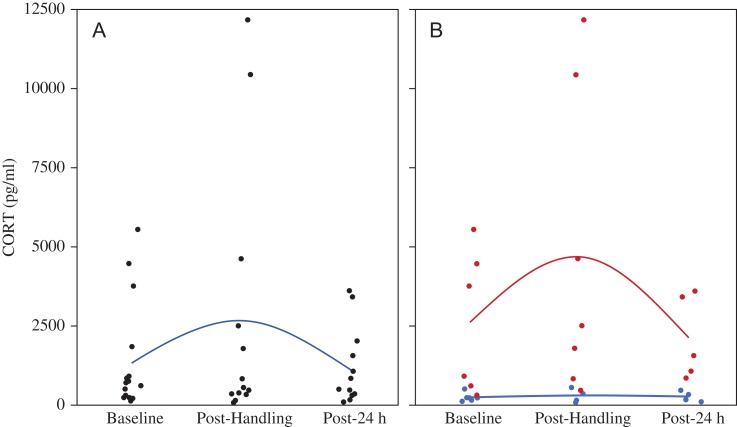
Plasma corticosterone (CORT) concentrations with mean trend line during the three sample periods for all animals combined (A) and separated for animals with a ‘strong’ stress response (≥75% quartile; red line) and for those with a ‘mild’ stress response (≤25% quartile; blue line) (B).